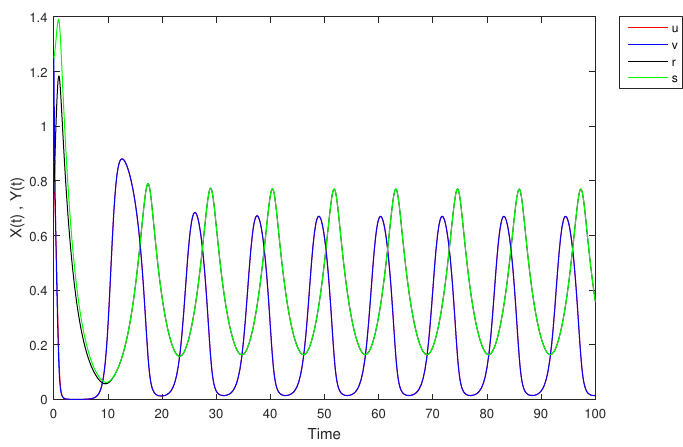
Figure 13. The solution of (7) at α = 0.5 as time increases.